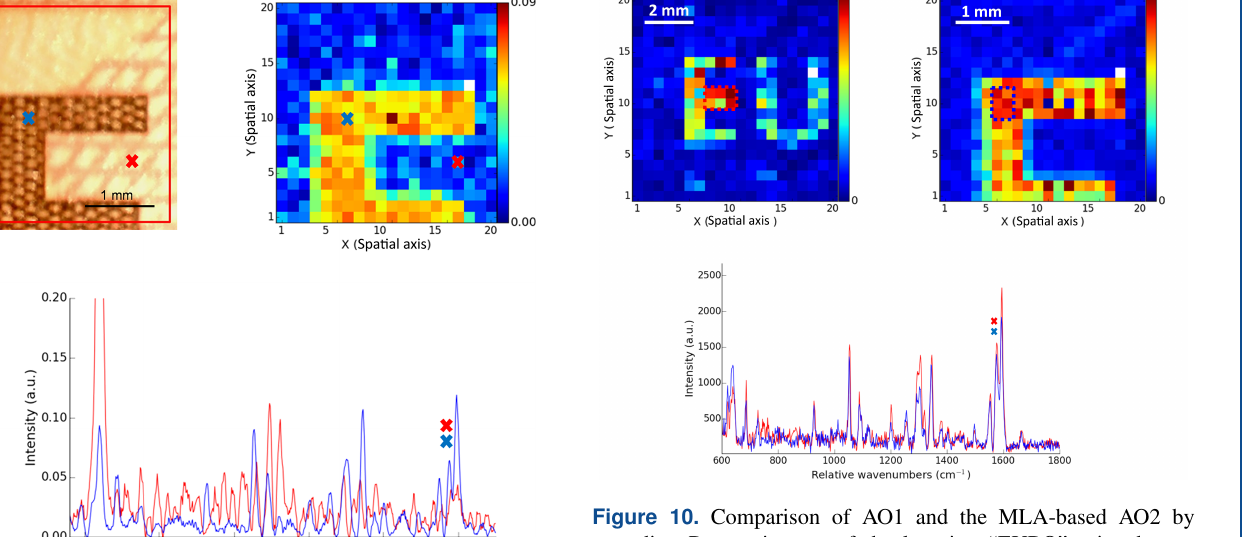
Fig. 7: Granules and powder of the pain reliever Aspirin Effect. Upper left: Camera picture. Upper right: Pseudo color Raman image of the intensity at 1606 cm -1 , which corresponds to the distribution of the agent acetylsalicylic acid. Below: Corresponding SERDS spectra at the positions and (1 s recording time per laser).